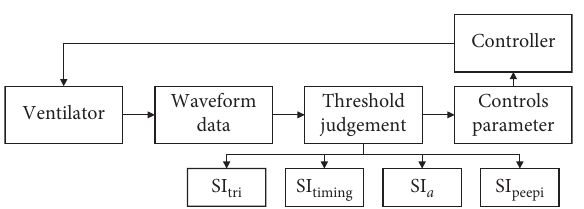
Figure 18: Controlling principle for using SI